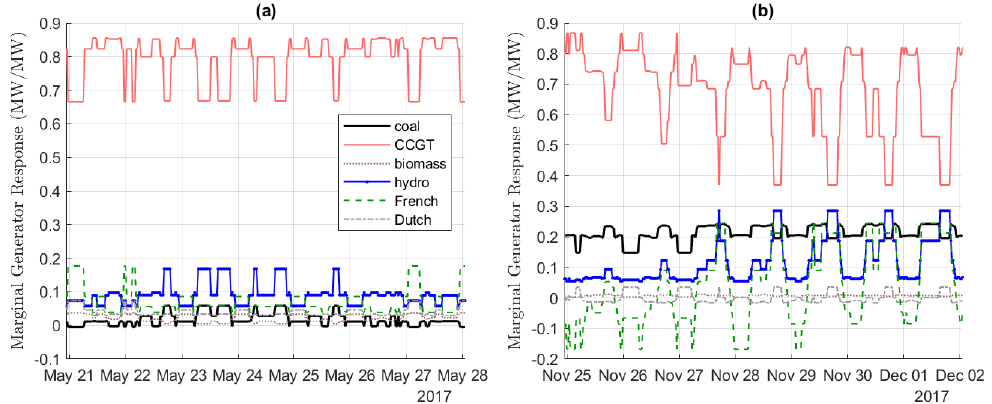
Figure 4. MGR ( t ) of coal, CCGT, biomass, hydroelectric, and French and Dutch